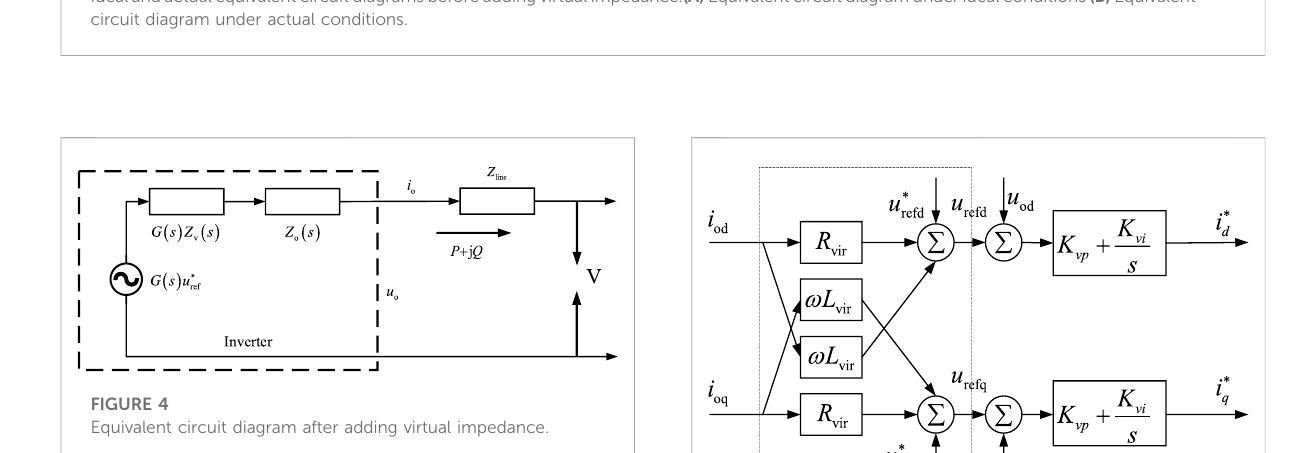
FIGURE 4 Equivalent circuit diagram after adding virtual impedance.